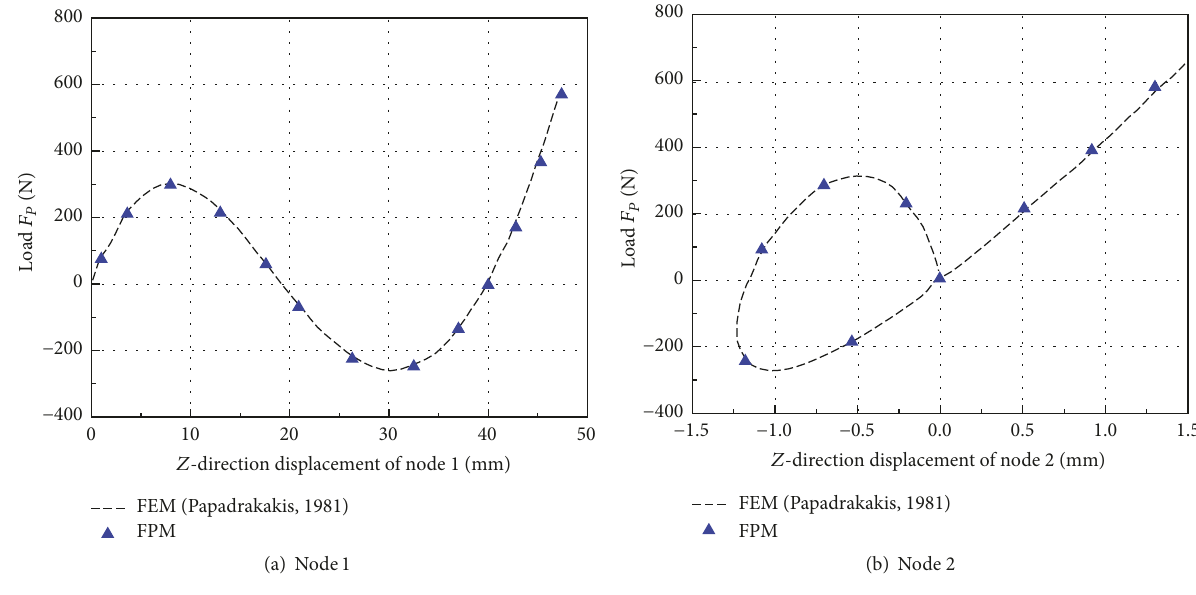
Figure 10: Load-displacement curves of node 1 and node 2 in the 𝑍